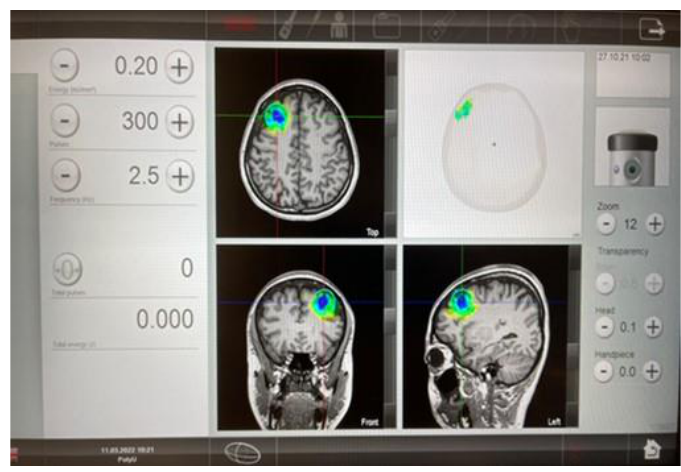
Figure 4. Subject’s fMRI (T1 images) after TPS intervention in our pilot study for MDD .